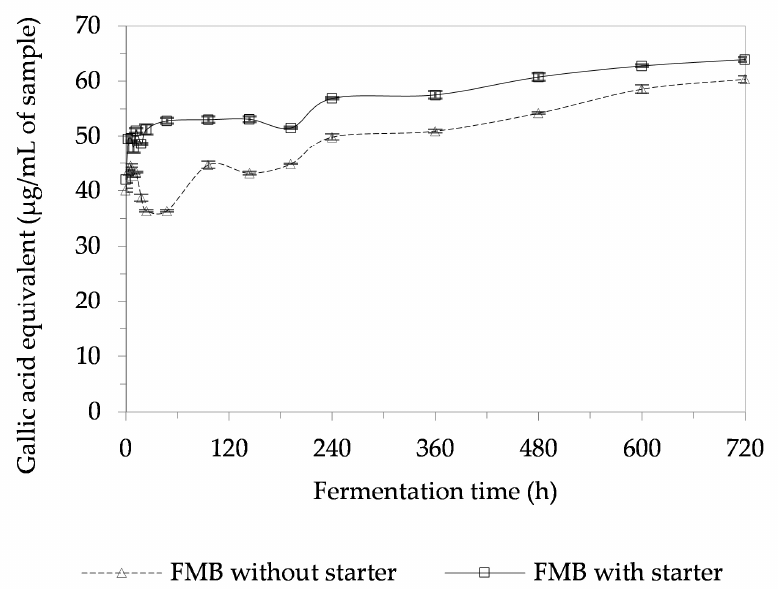
Figure 6. The change of total phenolic content (TPC) in a fermented mushroom beverage (FMB) with and without starter culture L. plantarum SK15 during fermentation time.